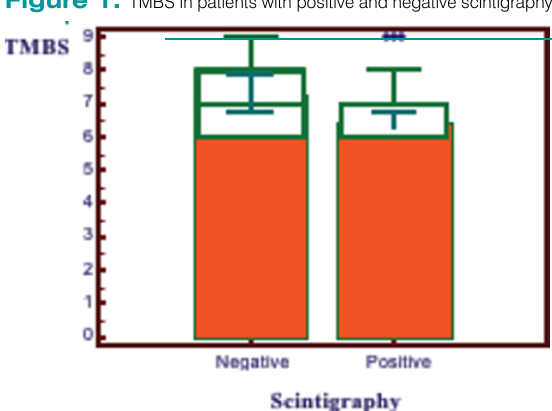
Figure 1. TMBS in patients with positive and negative scintigraphy